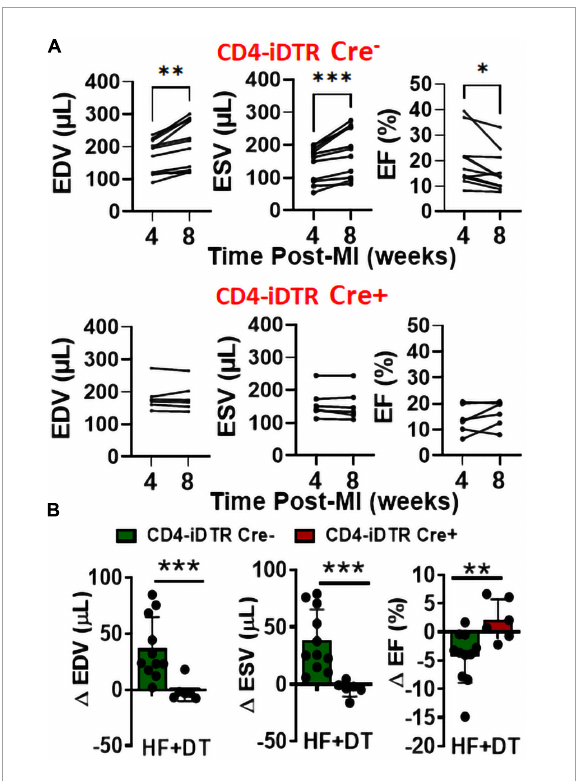
FIGURE3 (A) End-diastolic and end-systolic volumes (EDV and ESV) and ejection fraction (EF) of CD4-iDTR Cre - (littermate controls) and CD4-iDTR Cre + mice at 4 weeks (during randomization) post-MI and at 8 weeks after treatment with three doses (repeated every 10 days) of 400 ng DT. (B) Change in the EDV, ESV, and EF of CD4-iDTR Cre - (littermate controls) and CD4-iDTR Cre + mice from 4 to 8 weeks post-MI after treatment with three doses (repeated every 10 days) of 400 ng DT. CD4-iDTR Cre - mice were used as littermate controls and underwent similar DT injections. Mean ± SD is shown. Paired 2-tailed Student’s t -test was used in (A) whereas unpaired 2-tailed Student’s t -test was used in (B) . * p < 0.05, ** p < 0.01, and *** p < 0.001 represent significance with respect to indicated